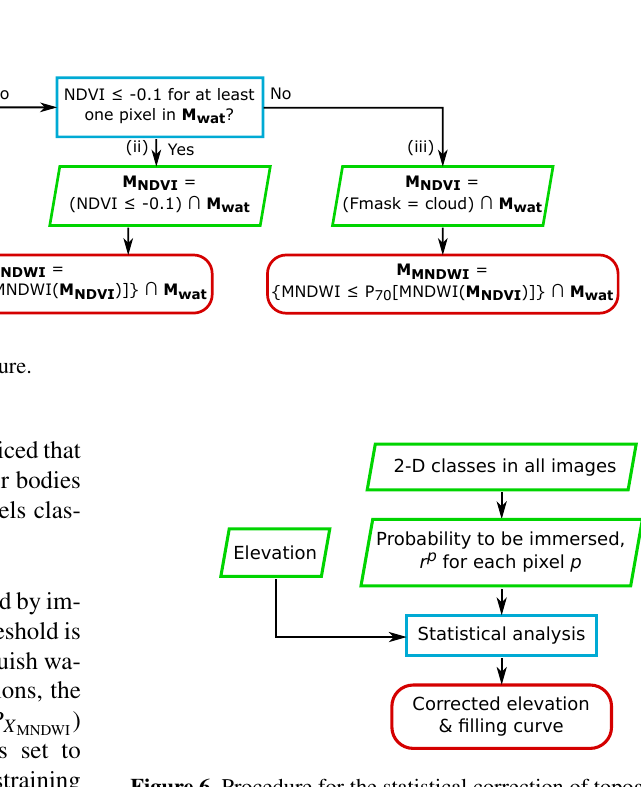
Figure 6. Procedure for the statistical correction of